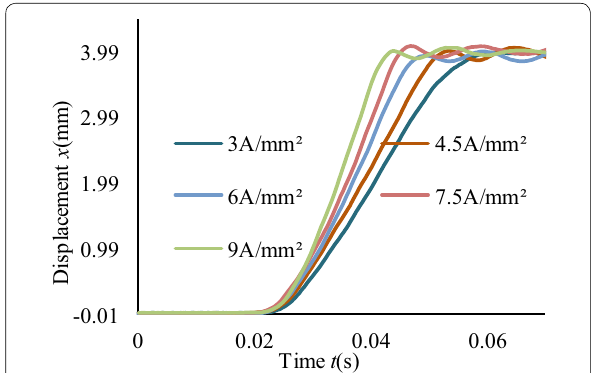
Figure 23 Displacement response of single winding